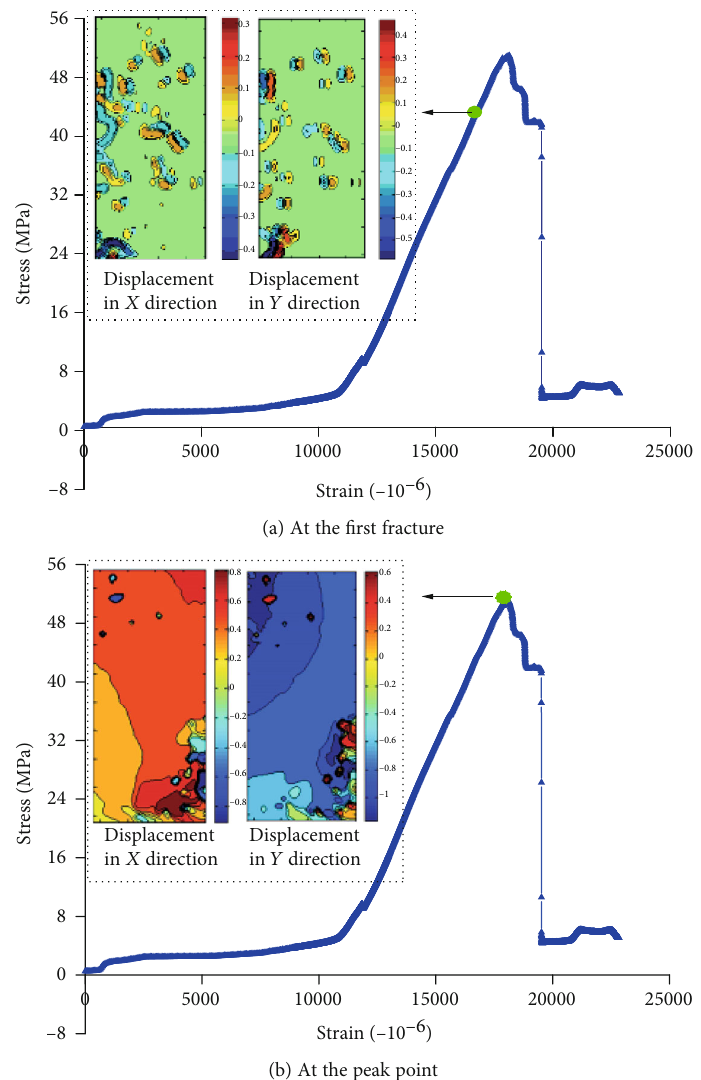
Figure 9: Displacement of specimen S3-2 by